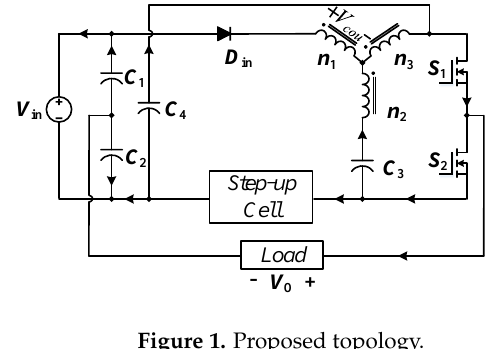
Figure 1. Proposed topology.